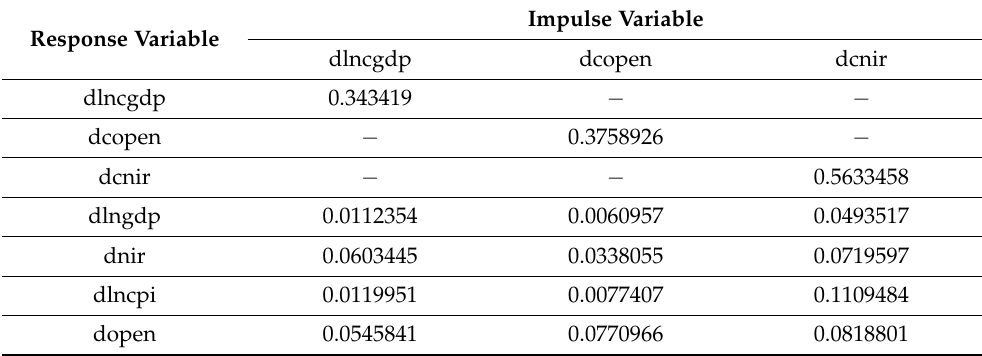
Table 10. Variance Decomposition PVAR (10 periods ahead) for GDP